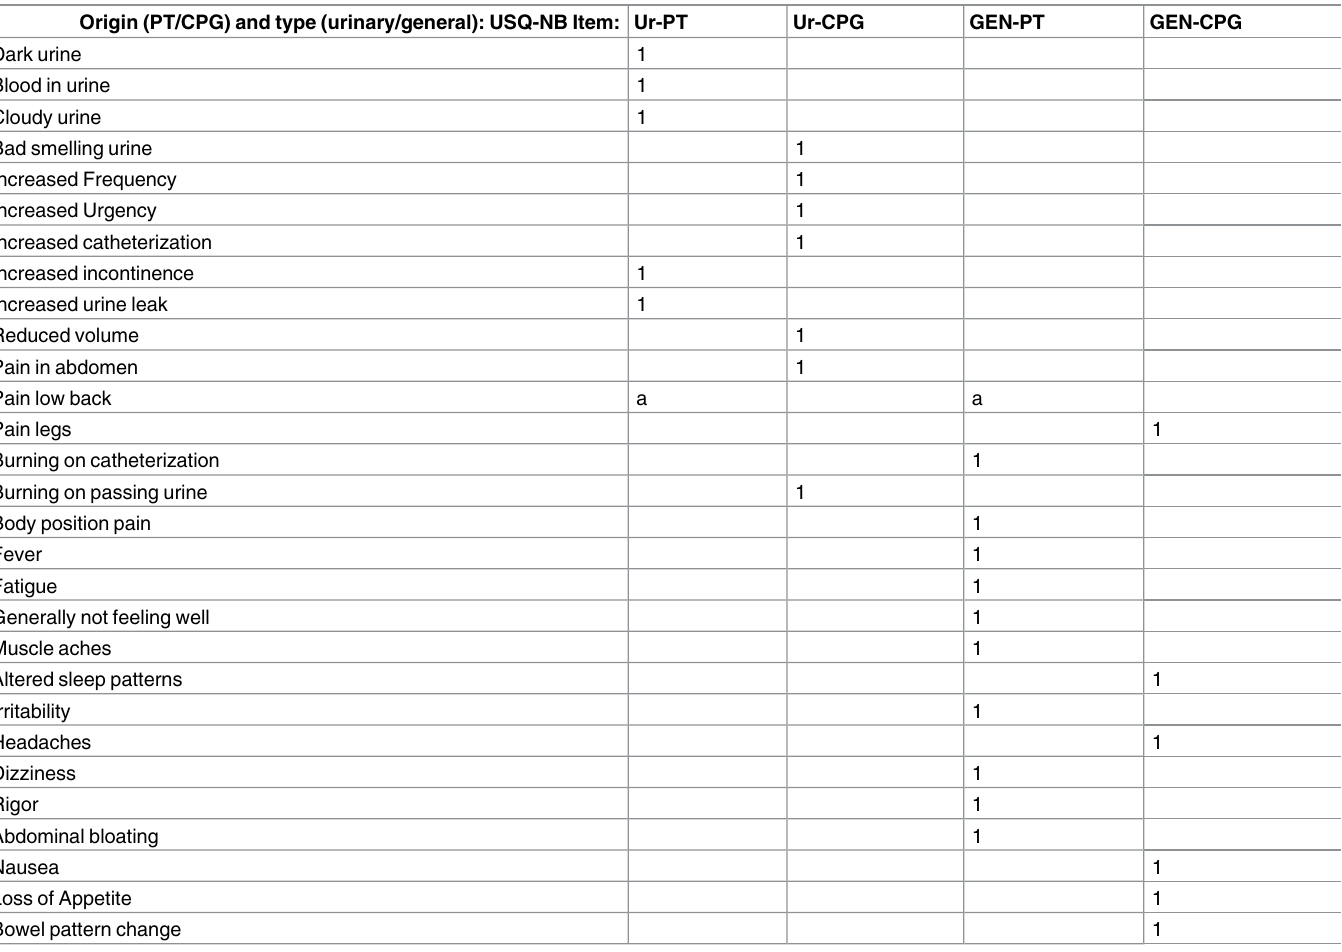
Table 2. Origins of items on the USQ-NB: Patients or clinical practice